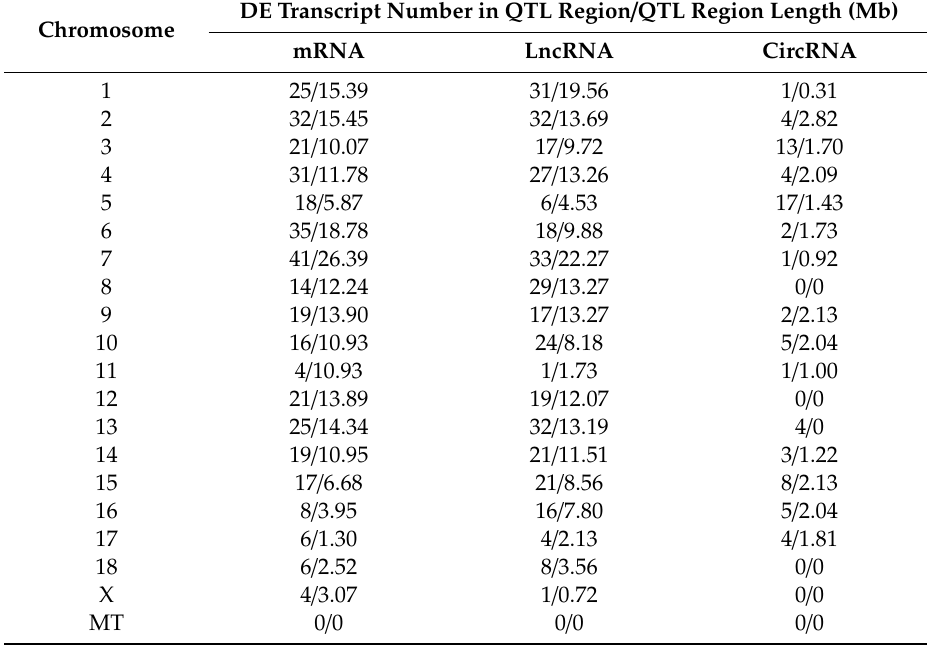
Table 3. Distribution of di ff erentially expressed transcripts in chromosome and QTLs region. DE Transcript Number in QTL Region / QTL Region Length (Mb) Chromosome mRNA LncRNA